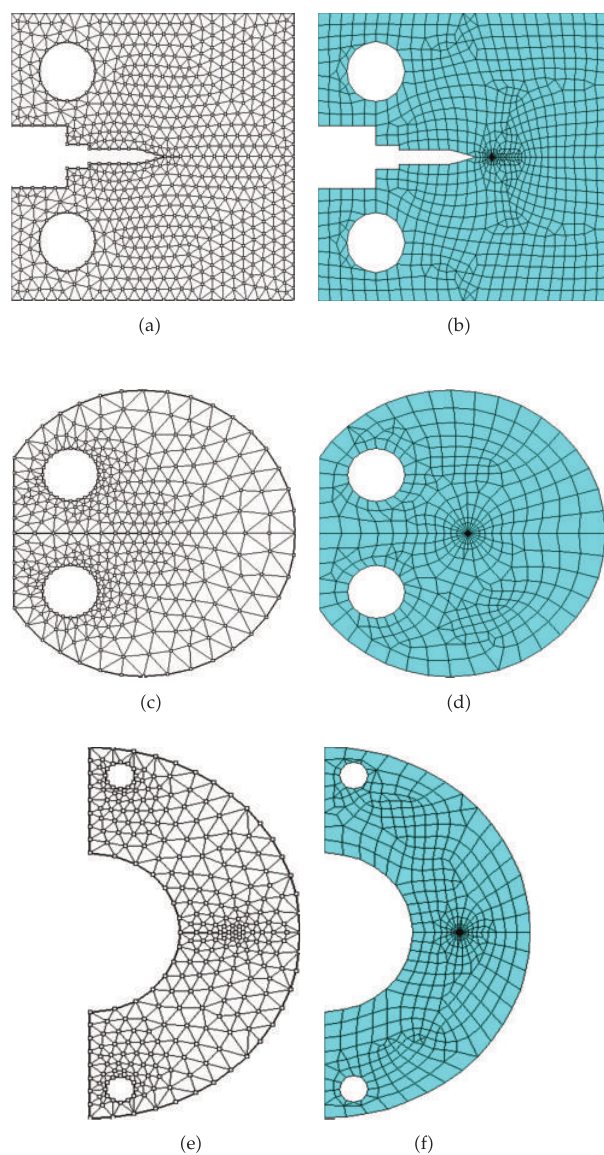
Figure 8: Scattered nodes and triangular background cells (cid:2) left hand side (cid:3) and finite element mesh (cid:2) right hand side (cid:3) for point loaded specimens with a/W (cid:11) 0 . 4.